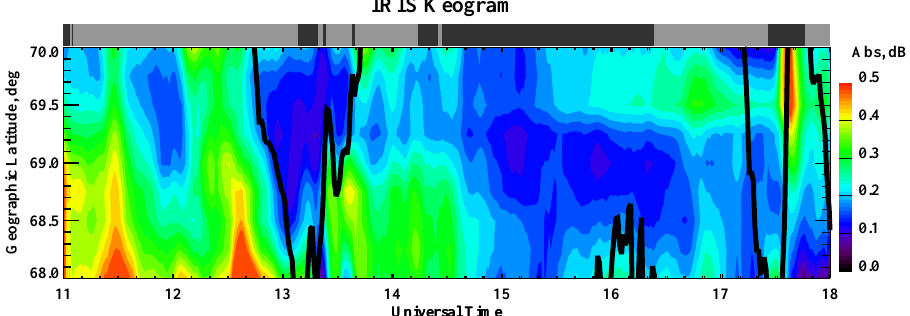
Fig. 5. The IRIS keogram at 23.0 ◦ E (geographic). The black line is a contour J = 0 from Fig. 4 representing the boundary between eastward and westward electrojets. On the top we reproduce the grey-scale shading from Fig. 3; the dark (light) grey shade corresponds to the time interval when time-lagged by 45min ACE IMF B z component was positive